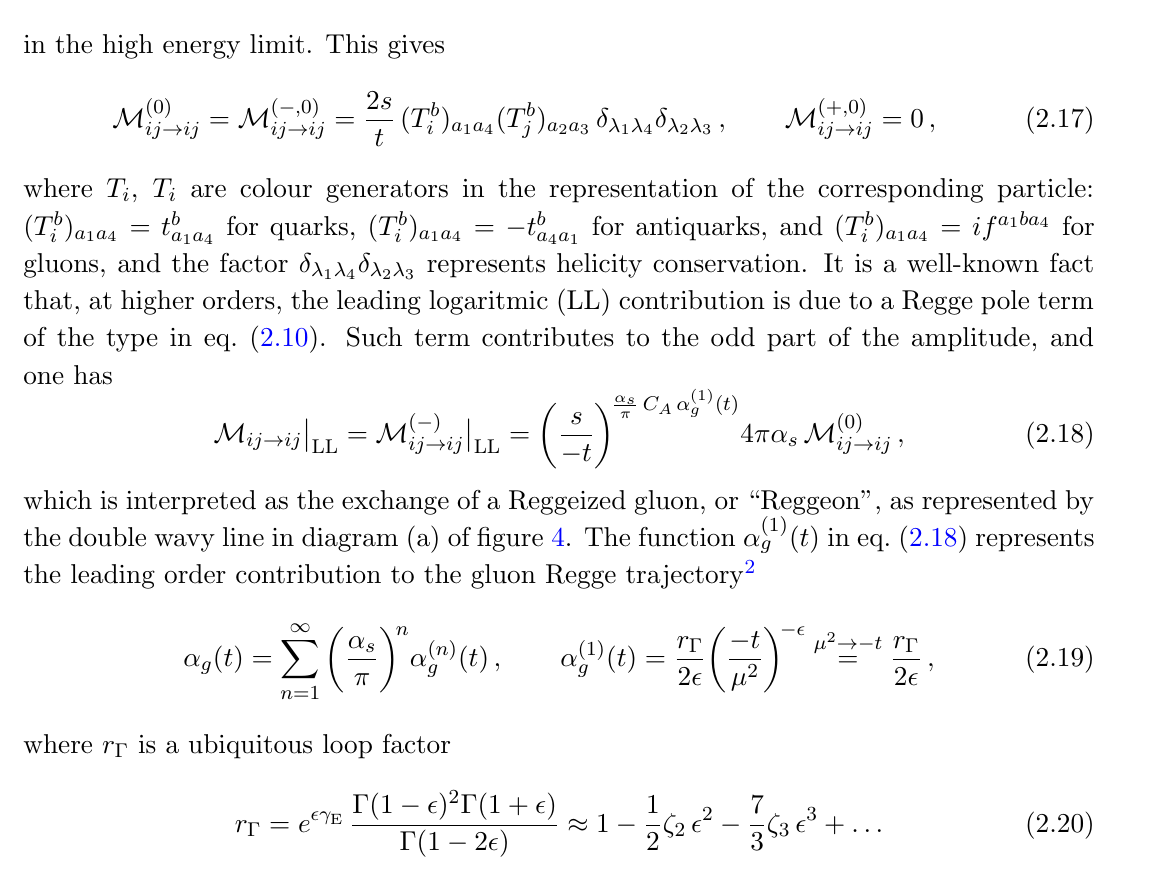
Figure 2 . Tree-level t -channel exchange contributing in the high-energy limit to quark-quark, quark-gluon or gluon-gluon scattering. The solid external lines represent either quarks or gluons, depending on the process